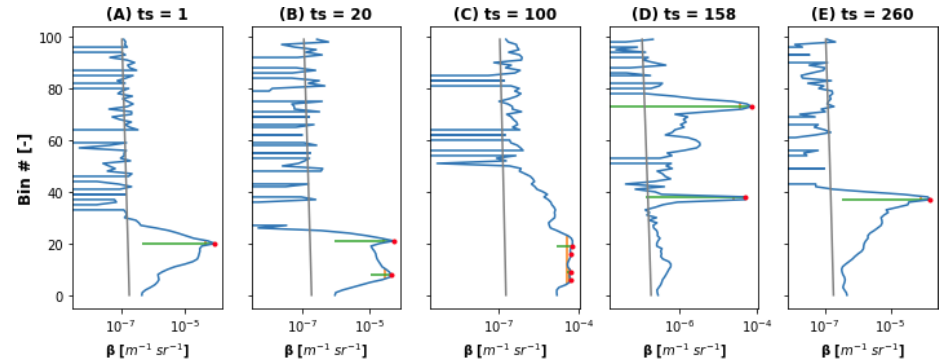
Figure 6. For 6 January 2019: selected vertical profiles of backscatter (A, B, C, D, E). Time steps are indicated as “ts” and can be converted to time by multiplying by 5min. Peaks are identified with a red dot, peak widths with a vertical orange line, and peak prominences with a horizontal green line. The baselines (lowest points on the green lines) were calculated as the lowest contour lines around the peak. To identify the peak characteristics, we used the signal processing tools of the Python library SciPy. The theoretical molecular backscattering was computed following Eq. (2) as found in Kuma et al. (2021a) and is shown in each panel as a solid grey line.